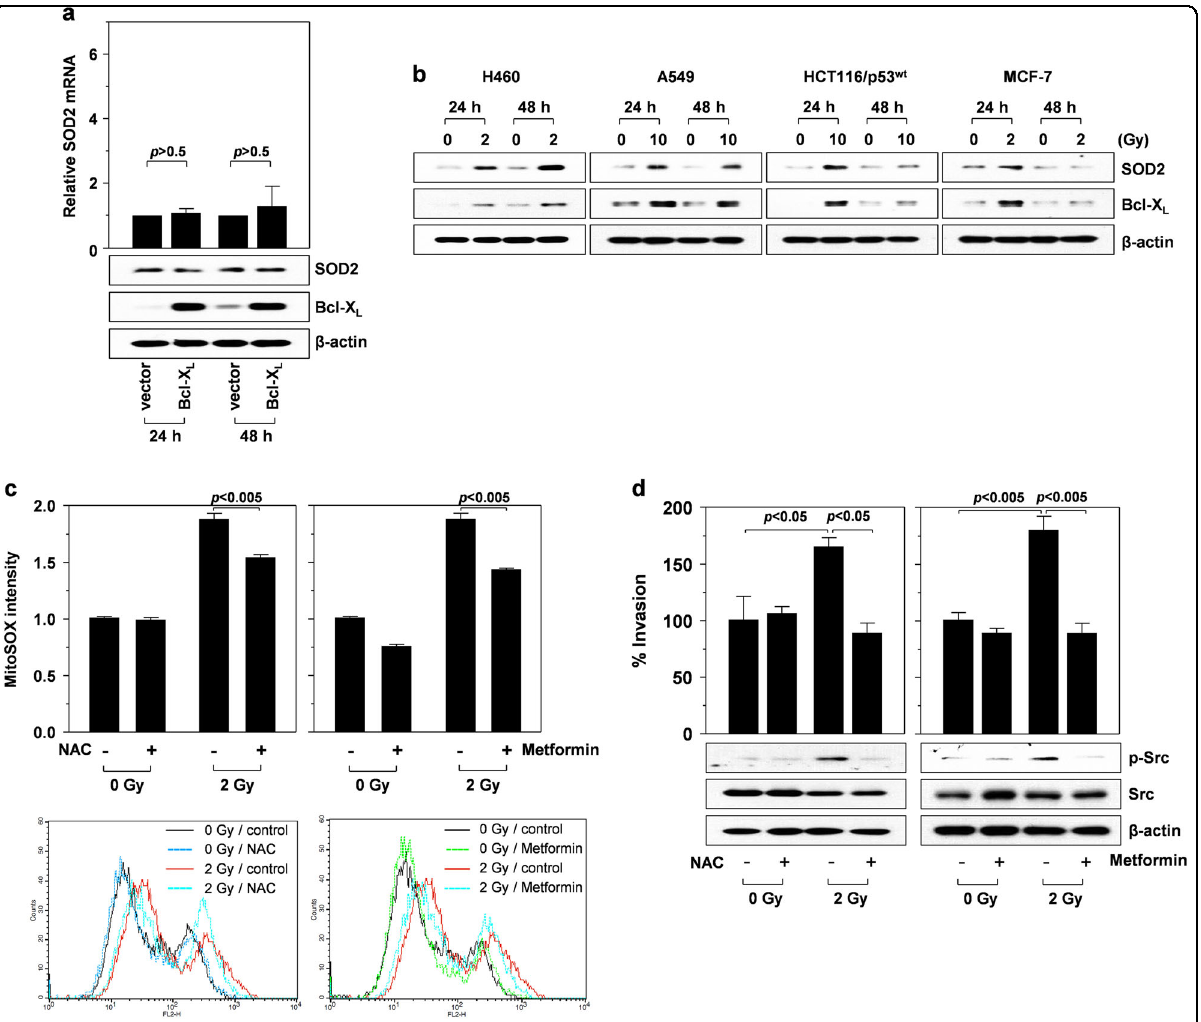
Fig. 3 IR induces the mitochondrial ROS/Src-dependent invasion pathway. a H460 cells were transfected with a control or a Bcl-X L -expression vector. After 24 and 48 h of incubation, SOD2 mRNA levels were compared by quantitative real-time PCR (top), and the levels of the indicated proteins were compared by western blotting (bottom). b The indicated cells were irradiated with the speci fi ed doses of γ -rays. Western blotting for SOD2 and Bcl-X L was performed at 24 and 48 h after irradiation. c Irradiated (2 Gy, 48 h) and untreated control H460 cells were incubated in the presence or absence of NAC (5 mM) and metformin (5 mM) for 1 h, and mitochondrial ROS levels were compared by staining cells with MitoSOX Red probes and analyzing them by fl ow cytometry. d Irradiated and untreated control cells were analyzed for their invasiveness in the presence or absence of NAC or metformin. The levels of Src and phosphorylated Src in the cells were compared by western